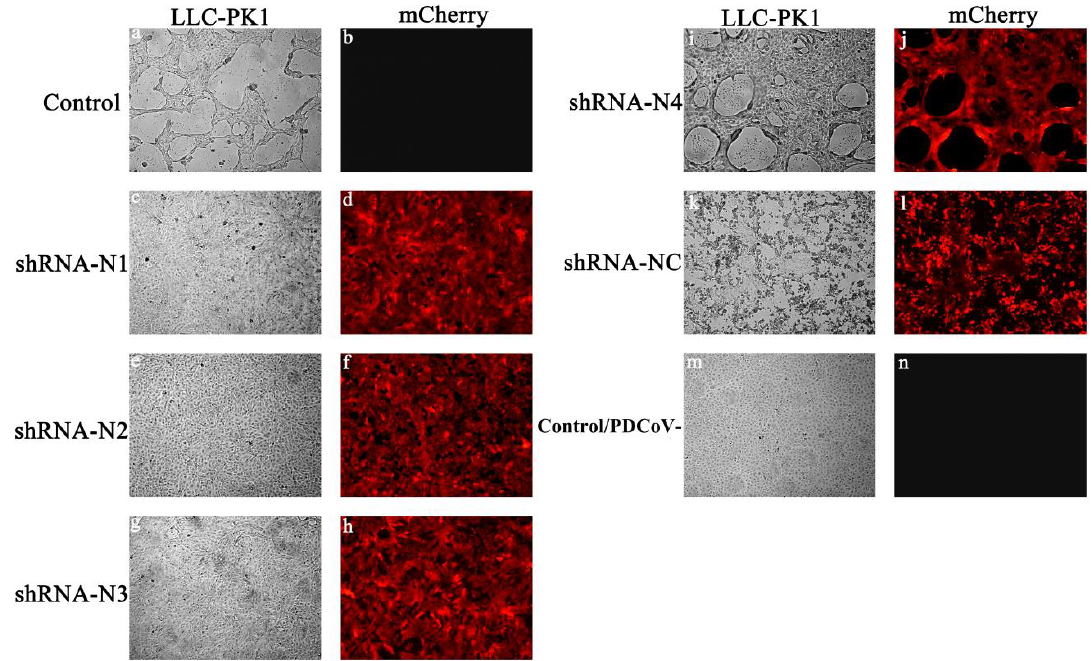
Figure 1. Fluorescence observation of CPE on LLC-PK1 cells transfected with shRNAs (100 × ). The LLC-PK1 cells were initially transfected with different plasmids carrying shRNA gene(s) and then infected with PDCoV at an MOI of 0.1, and CPE was observed at 36 hpi. ( a , b ) LLC-PK1 cells infected with PDCoV. ( c – l ) LLC-PK1 cells transfected with shRNA-N1, shRNA-N2, shRNA-N3, shRNA-N4, and shRNA-NC, respectively. ( m , n ) LLC-PK1 cells that were negative controls, that is, neither transfected with plasmids nor infected with virus.